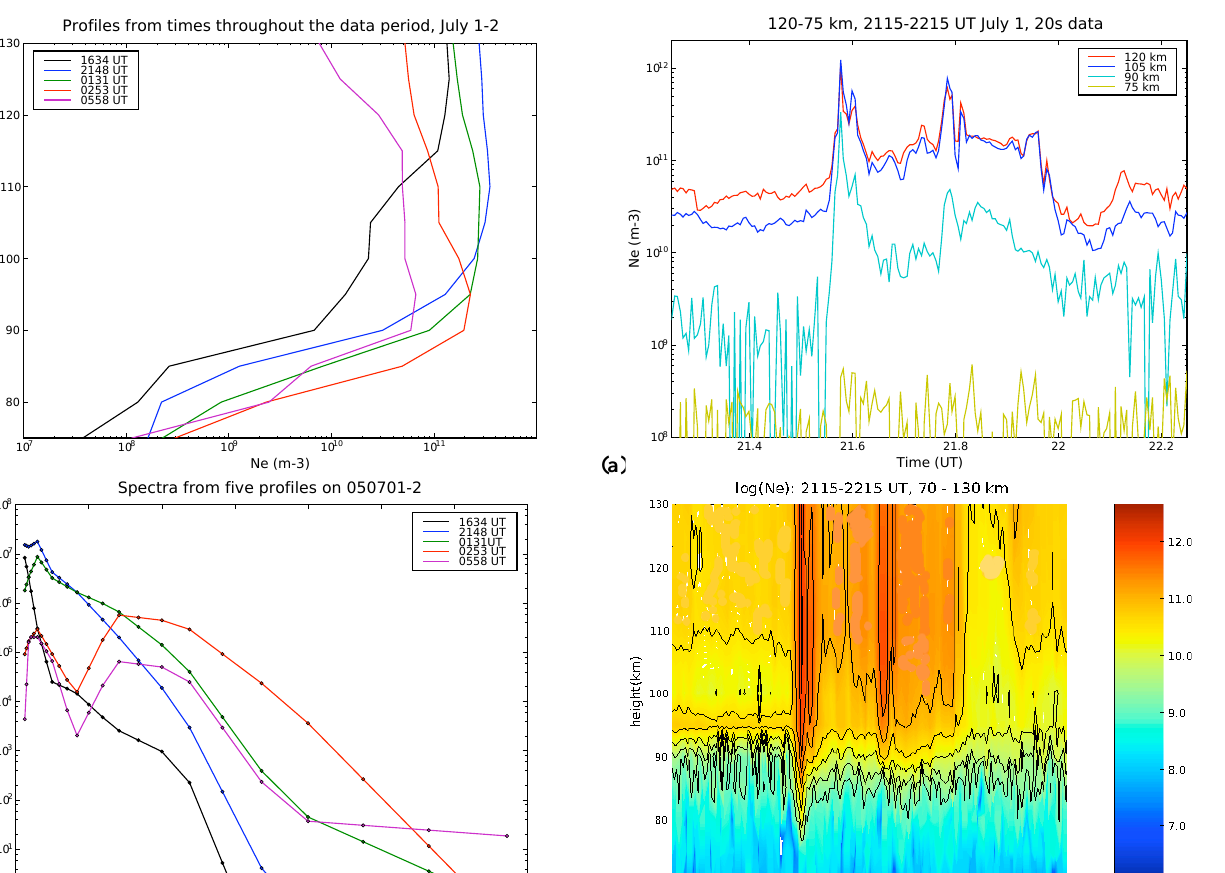
without, or with only weak, E-region peaks; these cor- respond with bursts of auroral absorption observed with the riometer. 5. At 05:58 UT: This morning event is weak at 90 km but hardly visible at all at 120 km, and it looks like the hard- est spectrum of the selection. The electron-density pro- file again peaks at relatively low altitude, where there has been a significant enhancement. There is not much effect in the E-region, the electron density seen in Fig. 2 being mainly due to the EUV contribution, with conse- quently a large E-region correction on Fig. 3a. Two other candidates (at 23:20 and 07:20 UT) were rejected because some of the readings at the lower altitudes were af- fected by